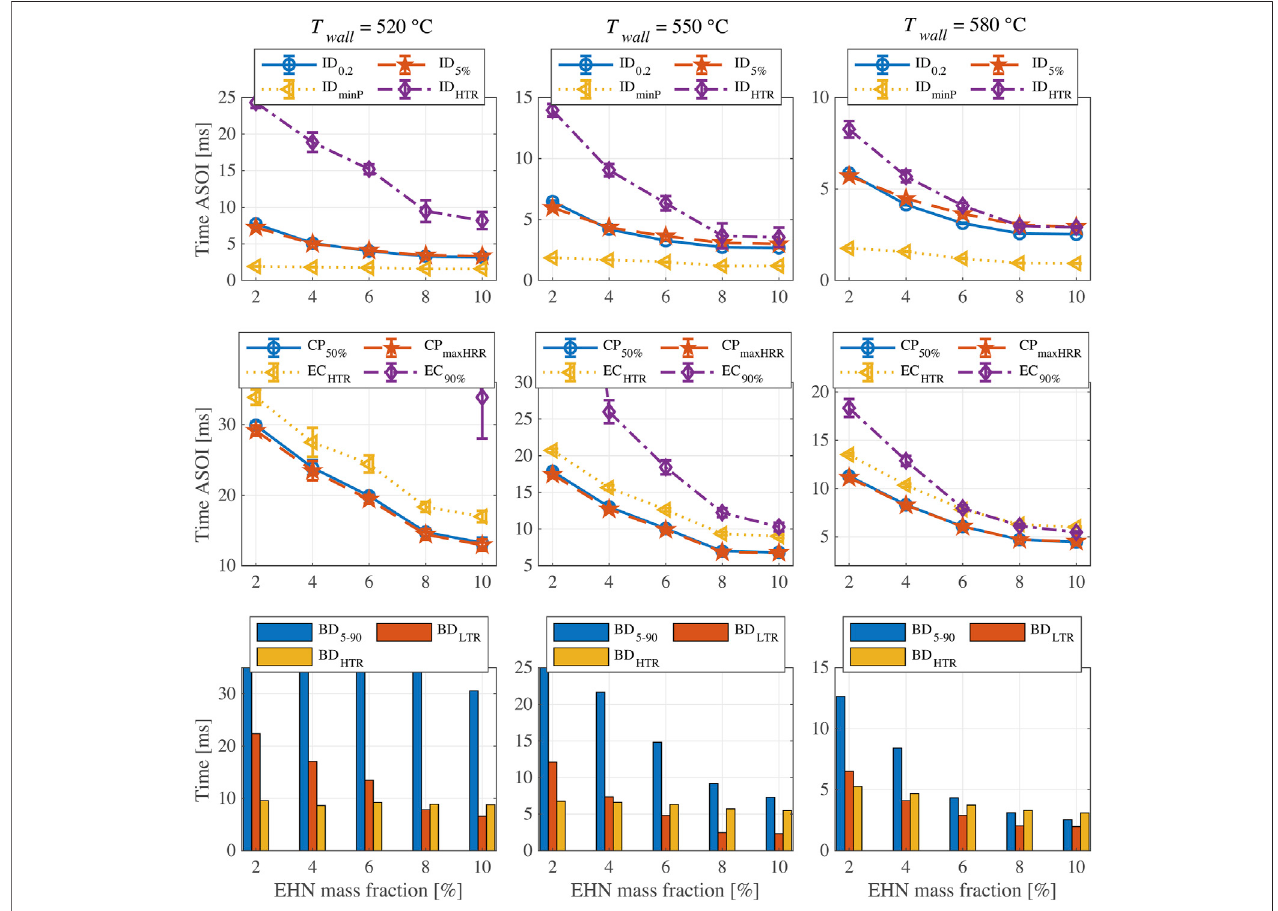
FIGURE 6 | Results of ignition and combustion indicators for n-butanol with addition of 2% – 10% EHN at different chamber wall temperatures.